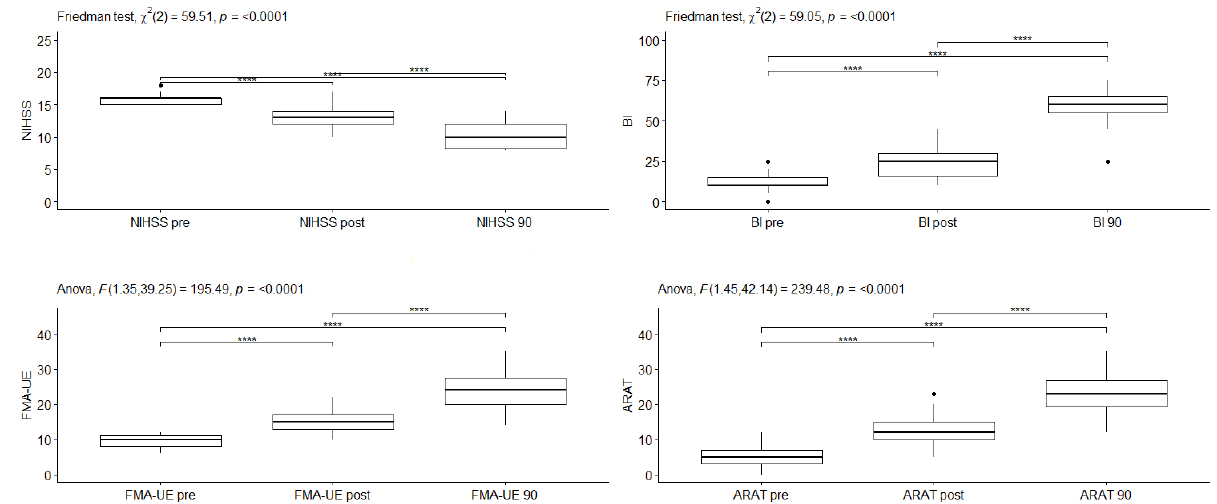
Figure 3. The changes in the outcome measures over time for NIHSS, BI, FMA-UE and ARAT in the Cerebrolysin group. **** p < 0.0001.